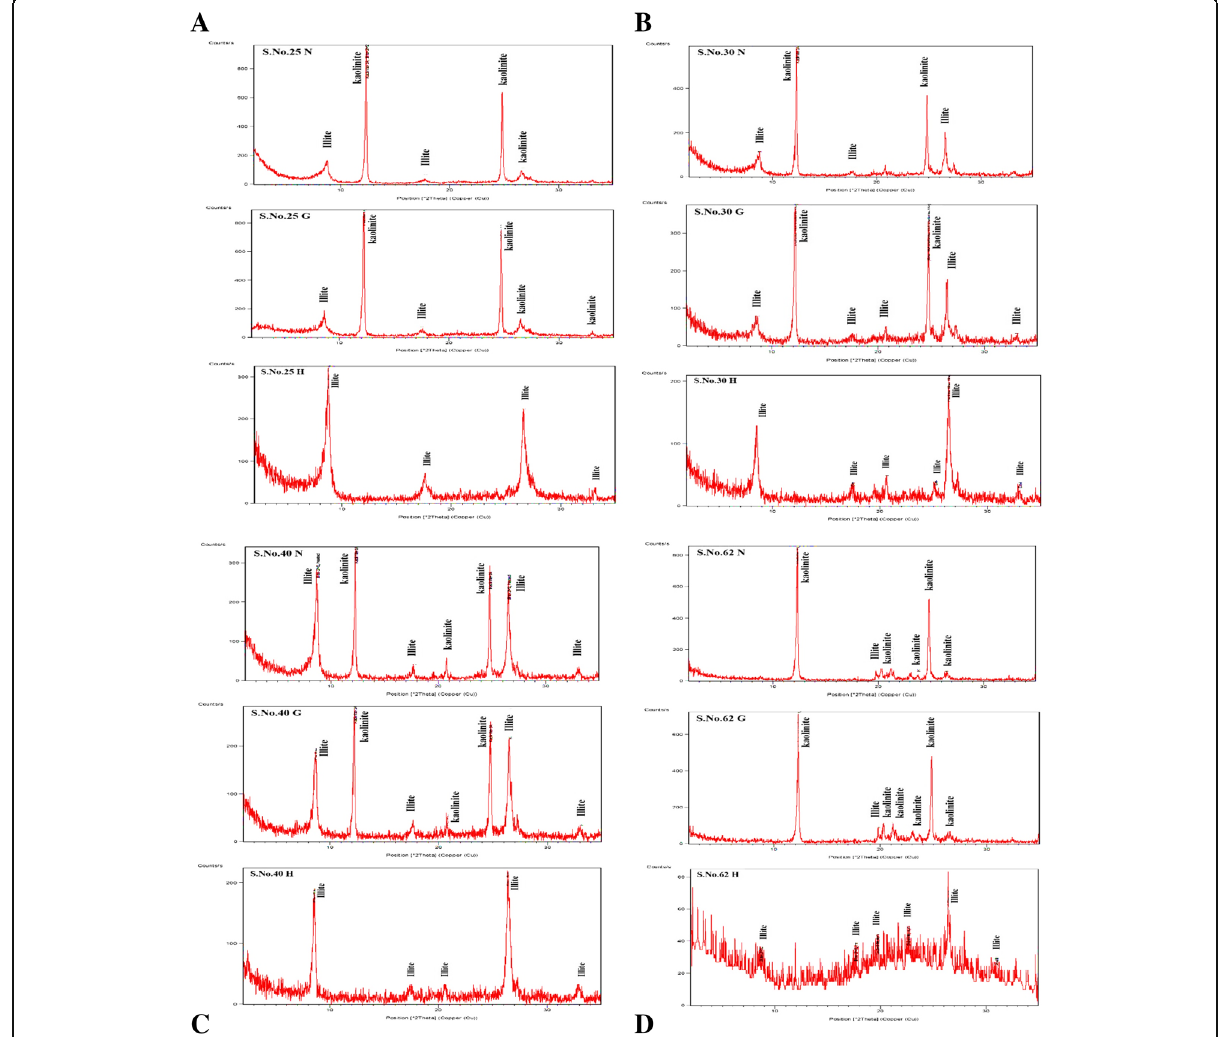
Fig. 3 X-ray diffraction pattern of oriented clay samples of Paleozoic mudrocks, a S. No. 25, b S. No. 30, c S. No. 40, and d S. No.